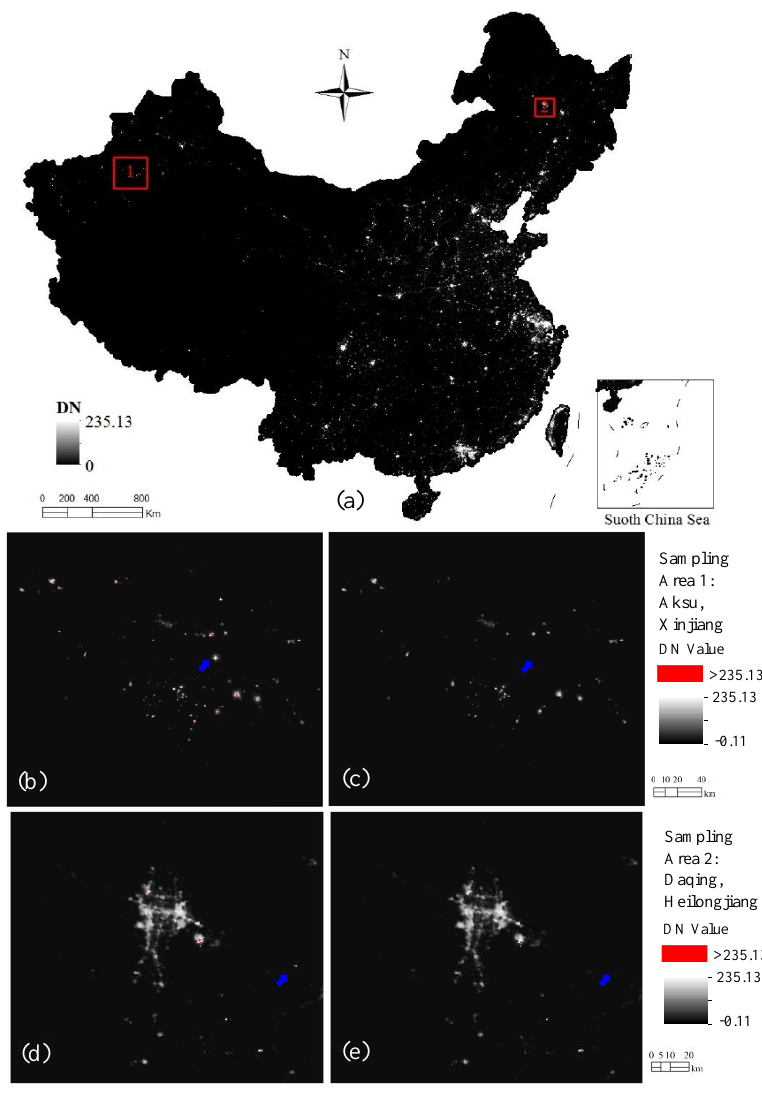
Figure 4. ( a ) The corrected NPP-VIIRS nighttime light data of China in 2012. Two regions bounded by red rectangles are Aksu, Xinjiang (sampling area No. 1) and Daqing, Heilongjiang (sampling area NO.2). The ( b ) original and ( c ) corrected image of sampling area NO.1; and the ( d ) original and ( e ) corrected image of sampling area No. 2. Two typical removed lit areas are pointed by blue